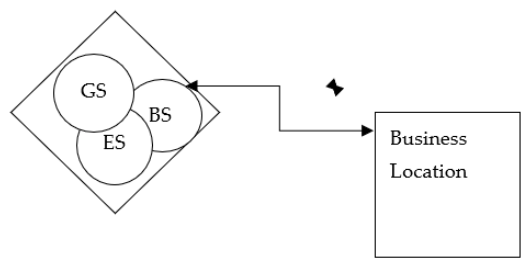
Figure 1. Conceptual framework. GS—government support. BS—business style. ES—entrepreneurial sustainability.